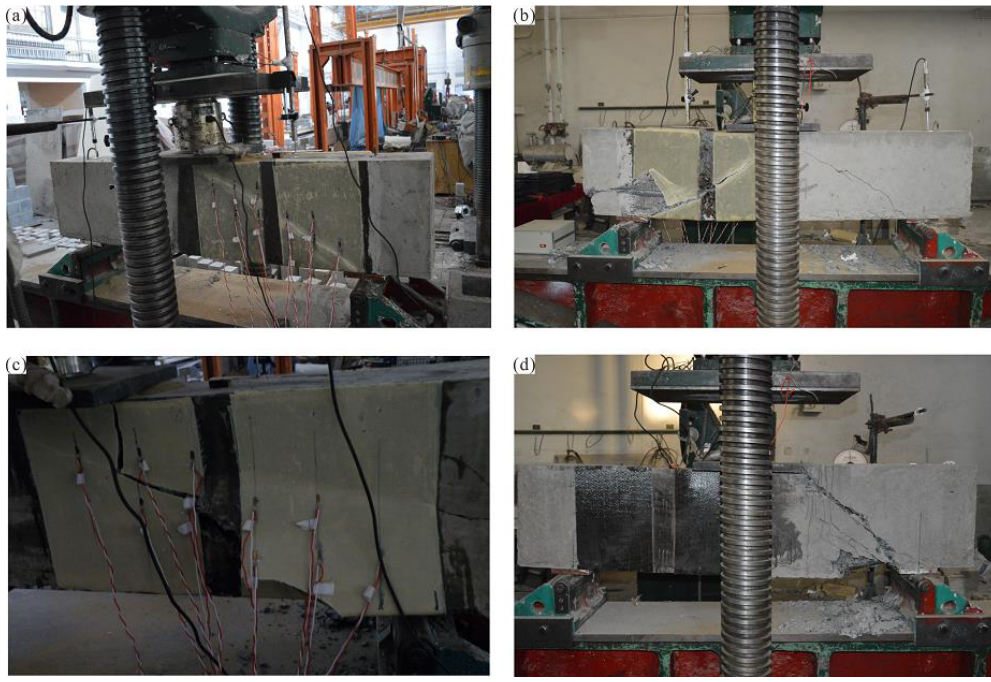
Figure 7. Failure mode of strengthened RC beam: ( a ) RC-FRP1, ( b ) RC-FRP3, ( c ) RC-FRP5, ( d ) RC-FRP6.